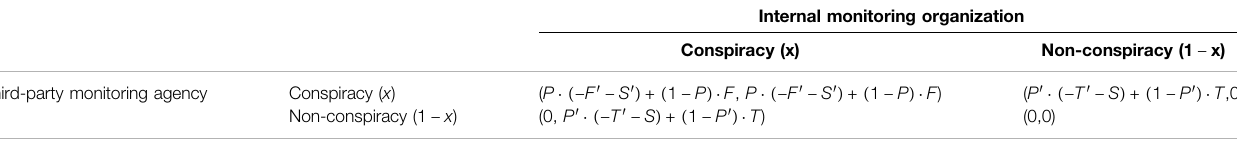
TABLE 1 | Payoff matrix between the third-party monitoring agency and the internal monitoring